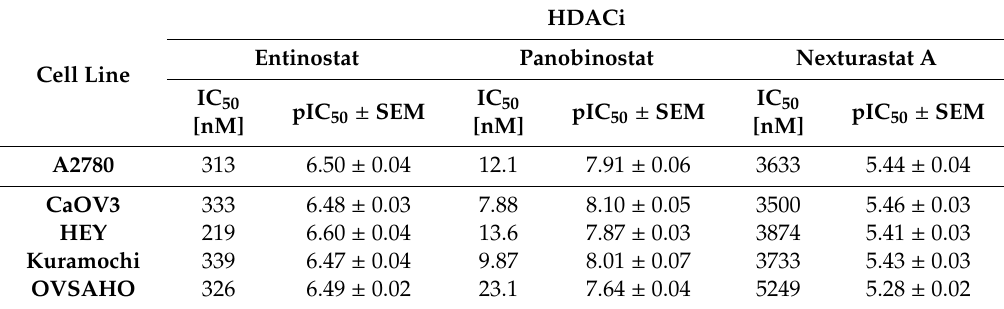
Table 3. HDAC inhibitory activity of entinostat, panobinostat, and nexturastat A.